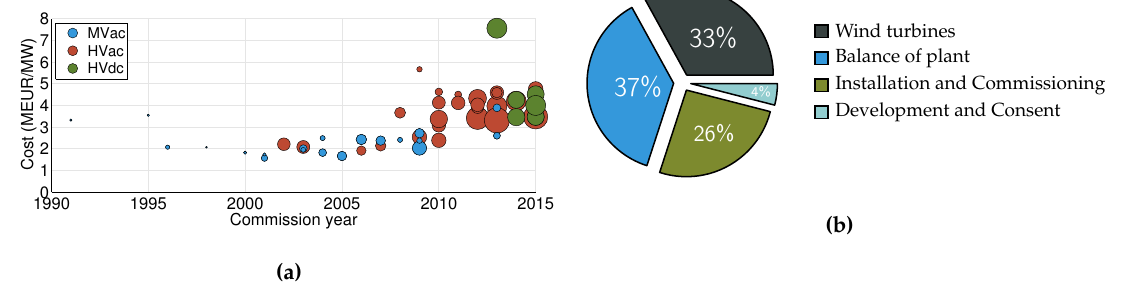
Figure 1. Cost of power (COP) and capital expenditure (CAPEX) breakdown of offshore wind farms (OWFs). ( a ) COP of the European OWFs composed of five or more turbines [10,11]. Circle size represents the installed capacity of the OWFs. The monetary values were updated considering a Eurozone inflation of 1.85% [12]; ( b ) Typical CAPEX breakdown of an OWF [13]. There are different measures that can decrease the costs of the energy generated offshore [2–6].